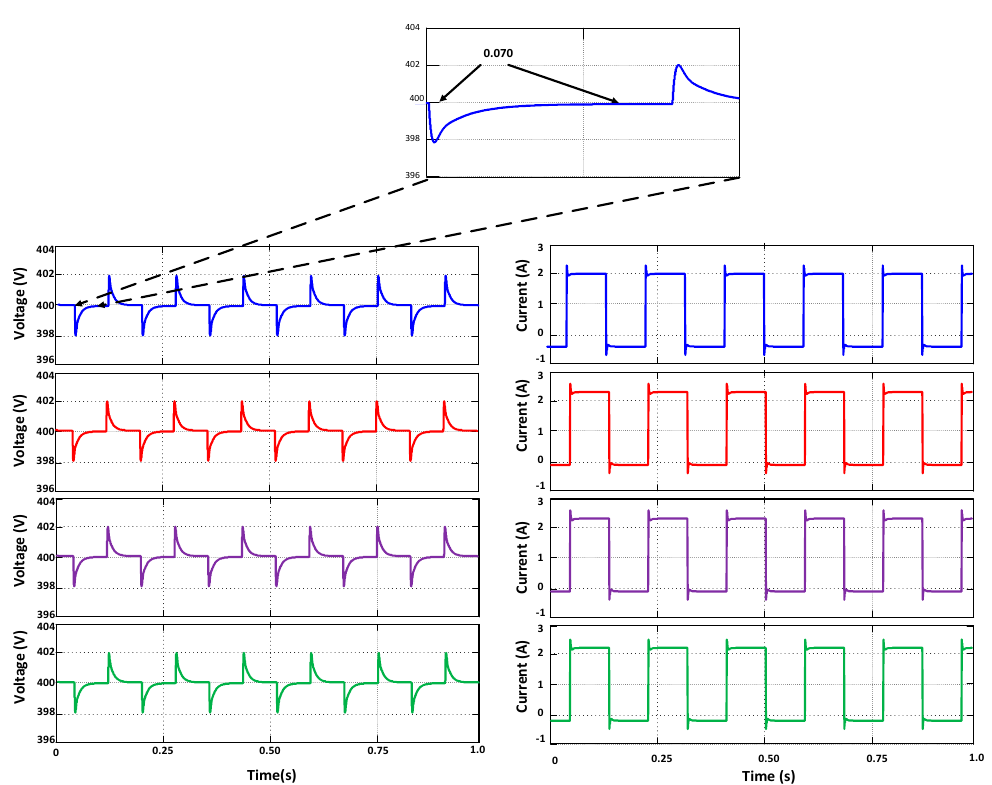
Figure 12. Current and voltage waveforms response of the existing technique [12] with disturbance signal. Electronics 2019 , 8 , 187 18 of 21